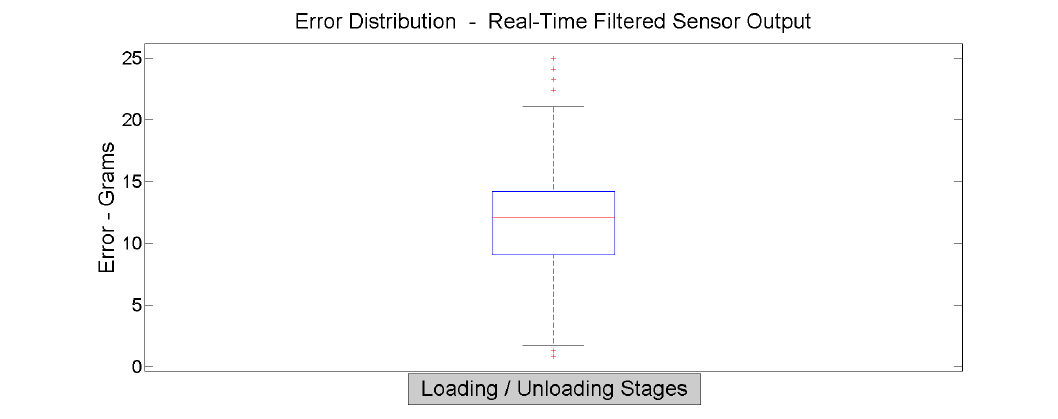
Figure 15. The filtered sensor output error